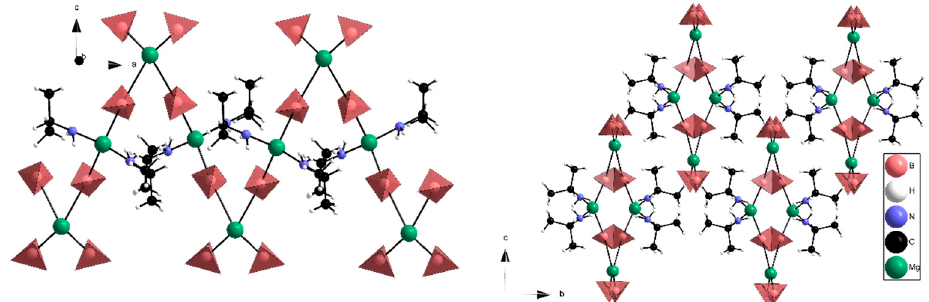
Figure 2. Experimental structure of Mg(BH 4 ) 2 · (CH 3 ) 2 CHNH 2 viewed in the a - c plane ( left ) and b - c plane ( right ). In the a - c plane the chain-like structure with alternating Mg 2+ environments is visible. The b - c plane shows how the chains arrange to form flat polar helixes, which are surrounded by apolar regions. Atoms: magnesium (green), carbon (black), nitrogen (blue), BH 4 − (red tetrahedron) and hydrogen (white).